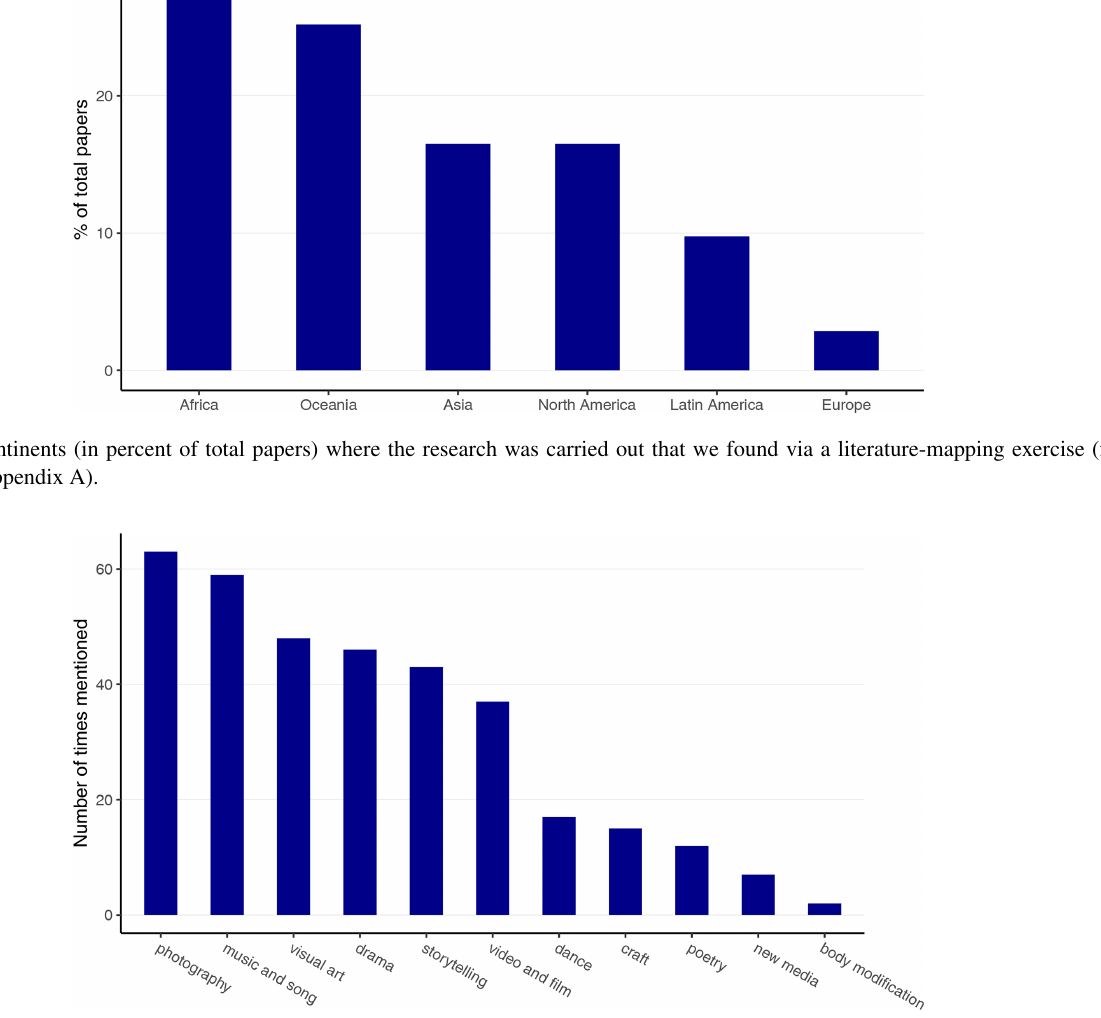
Figure 3. Art forms or creative methods used or researched (in no.; multiple art forms per paper are possible) in the journal articles that we found via a literature-mapping exercise (for details, see Appendix